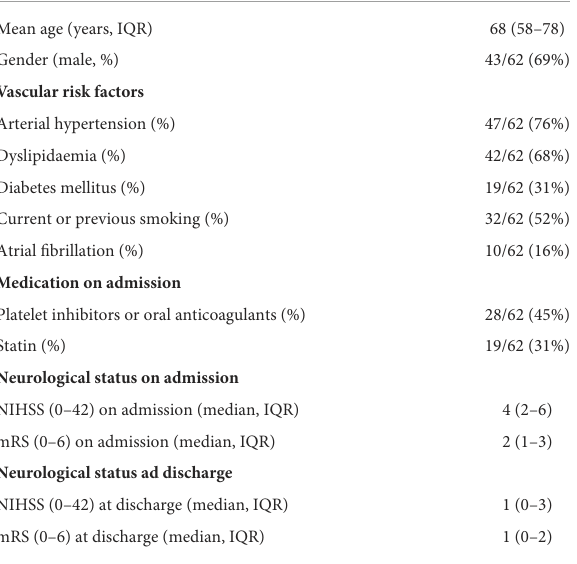
TABLE 1 Baseline characteristics of all ( N = 62) patients included in the